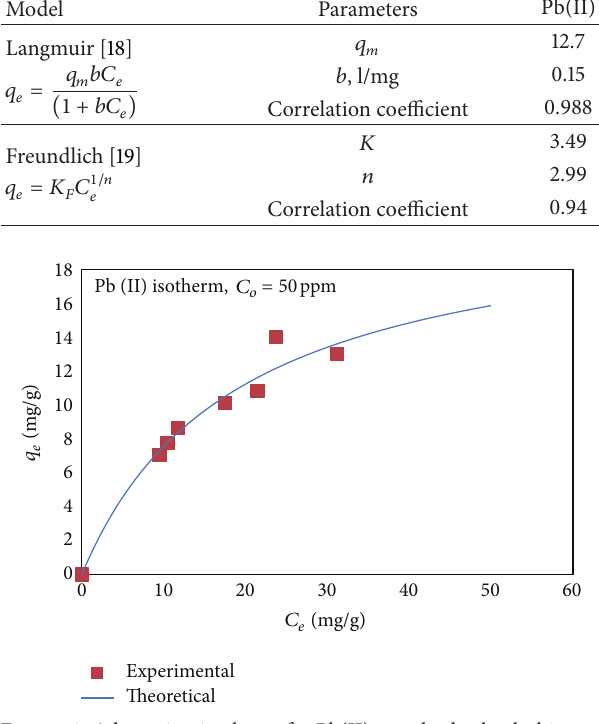
Figure 2: Adsorption isotherm for Pb(II) onto barley husks biosor-